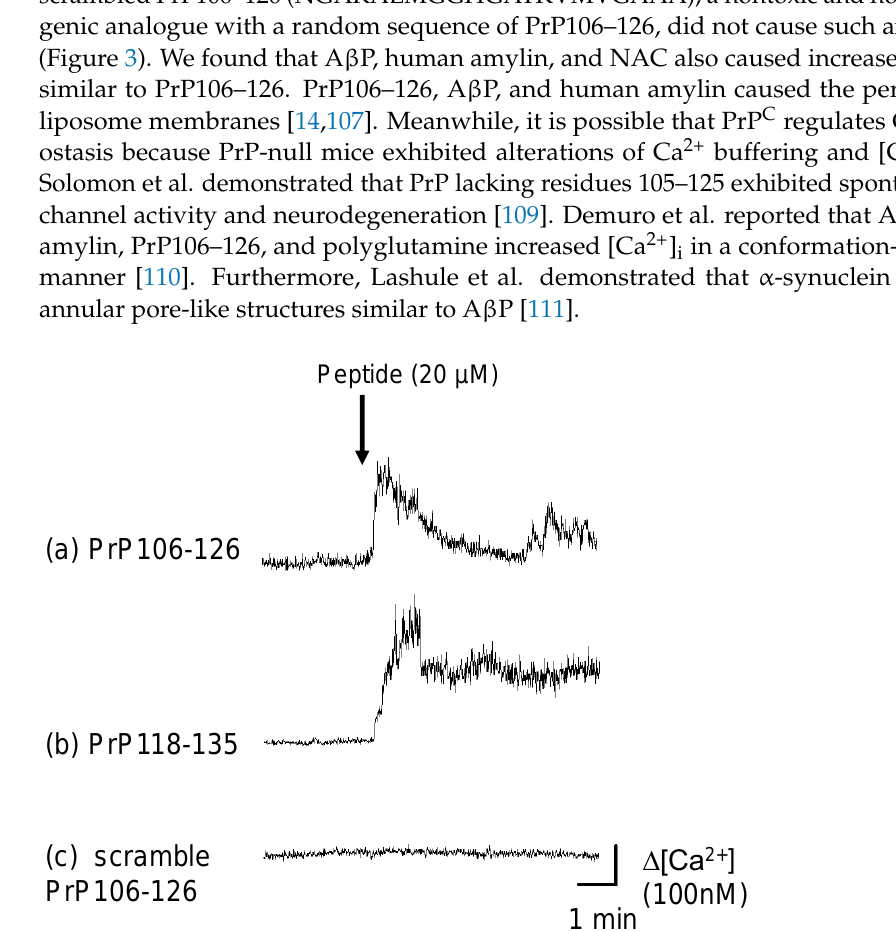
Figure 3. Temporal changes in intracellular calcium concentration ([Ca 2+ ] i ) in GT1-7 cells after exposure to PrP peptides. Temporal changes in fluorescence intensities corresponding to changes in [Ca 2+ ] i of typical GT1-7 cells before and after exposure to each PrP peptide (20 µM). ( a ) PrP106–126; ( b ) PrP118–135; ( c ) scrambled PrP106–126. The arrow indicates the time of peptide addition.